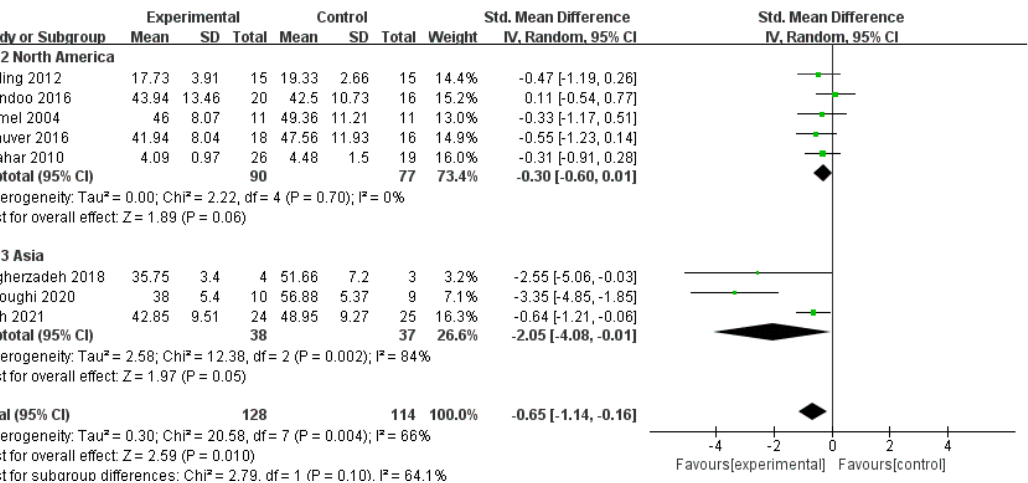
Figure 5. Meta − analyses of the effects of MBIs on rumination between North America and Asia [30,33–35,39,41,46,47].